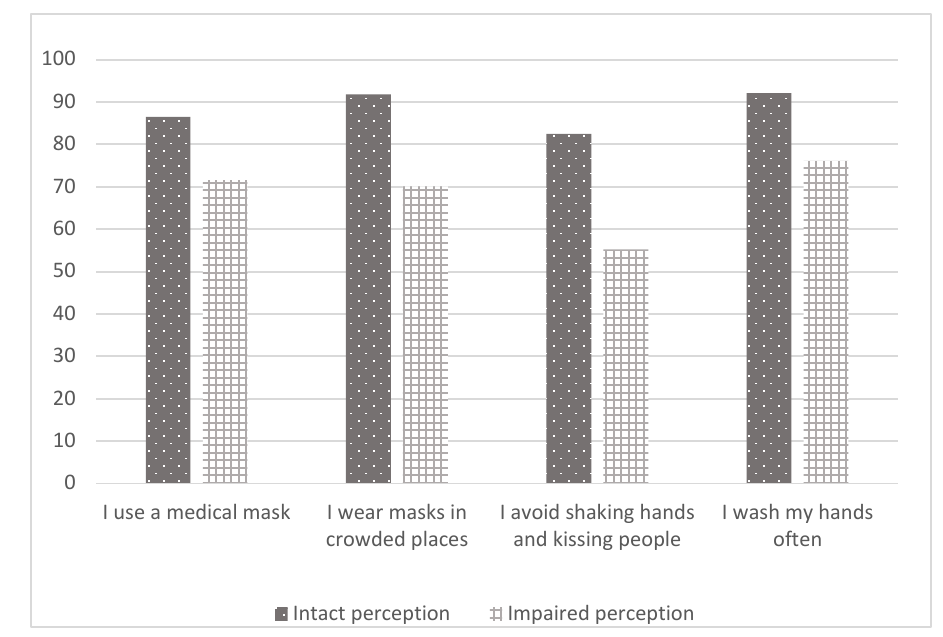
Figure 1. The association of COVID-19 perceptions with attitudes.